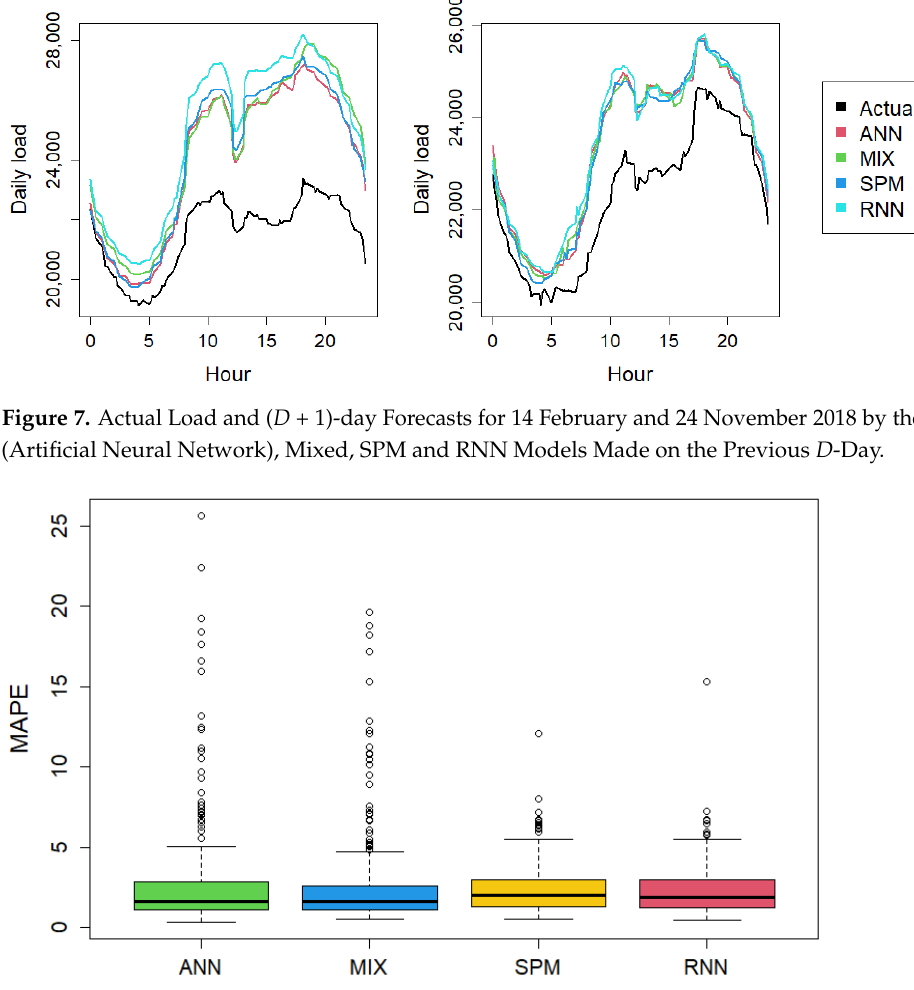
Figure 7. Actual Load and ( D + 1)-day Forecasts for 14 February and 24 November 2018 by the ANN (Artificial Neural Network), Mixed, SPM and RNN Models Made on the Previous D -Day.